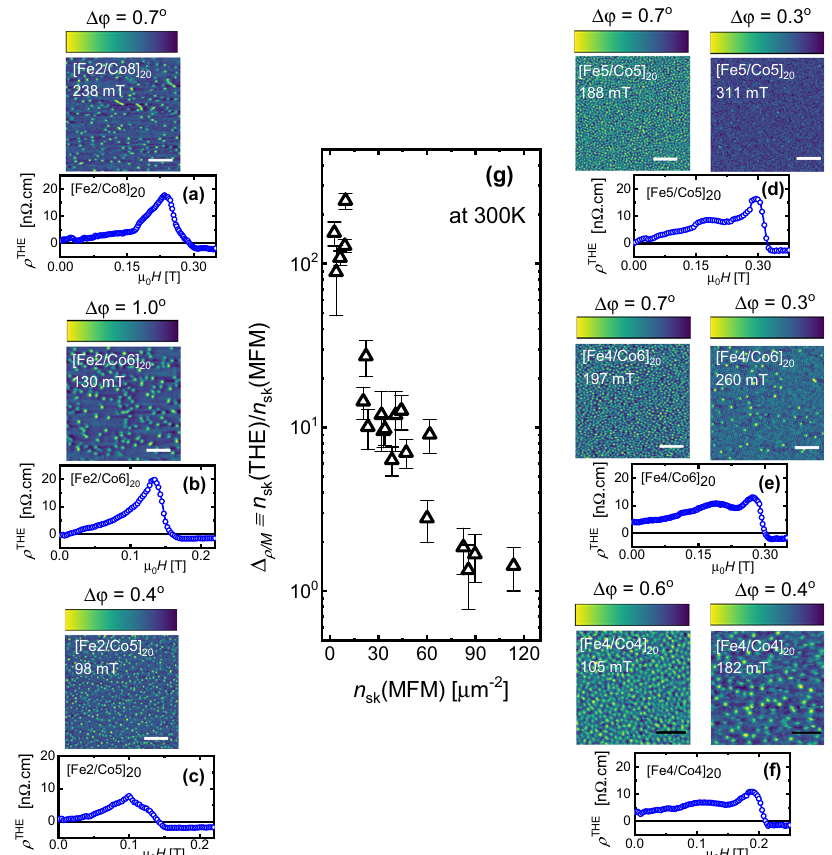
Fig. 1 Enhanced topological Hall resistivity ( ρ THE ) for isolated skyrmions compared with dense skyrmion arrays. a – c ρ THE ( H ) of isolated skyrmion con fi gurations observed in [Fe2/Co8] 20 , [Fe2/Co6] 20 , and [Fe2/Co5] 20 . d – f ρ THE ( H ) of dense skyrmion arrays observed in [Fe5/Co5] 20 , [Fe4/Co6] 20 , and [Fe4/Co4] 20 . g Δ ρ /M ≡ n sk (THE)/ n sk (MFM) estimated from transport and imaging experiments shown in ( a – f ) and in Section 1 of the Supplementary Information. n sk (THE) is given by ρ THE /( P ⋅ R 0 ⋅ Φ 0 ) with P = 0.56 and n sk (MFM) is estimated from MFM images; details of our image analysis methods can be found in our earlier reports 5, 9, 30 . The detailed evolution of magnetic textures with H can be found in Section 1 of the Supplementary Information. Scale bars in white (MFM images corresponding to ( a – e )) are 1 μ m and in black (MFM images corresponding to ( f )) 0.5 μ m. All the images are acquired at a scan height of 20 nm. The color scale represents the phase shift in the MFM signal due to the magnetic force acting on the tip. The ρ THE ( H ) pro fi les show a small non-zero offset ≤ 2 n Ω cm above the saturation fi eld of the magnetization ( H > H s ): this is a systematic offset due to our fi tting procedure (which is designed to avoid any “ false positive ” THE detection) and hence re fl ects the maximum error in the magnitude of ρ THE ( H ) shown in Fig. Figure 2a depicts the T − κ space and hence the wide range of spin textures, which we can experimentally access by varying T (5 – 300 K), the Fe/Co thickness ratio, and the number of repeats